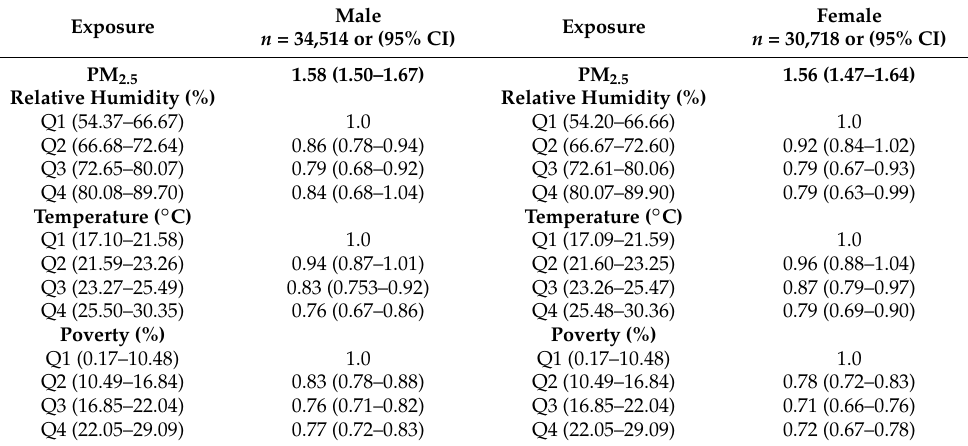
Table 4. Conditional regression analysis for a 10 µ g/m 3 increase in extrauterine PM 2.5 using a 6-month exposure window and O/O cases in Lima and Callao by